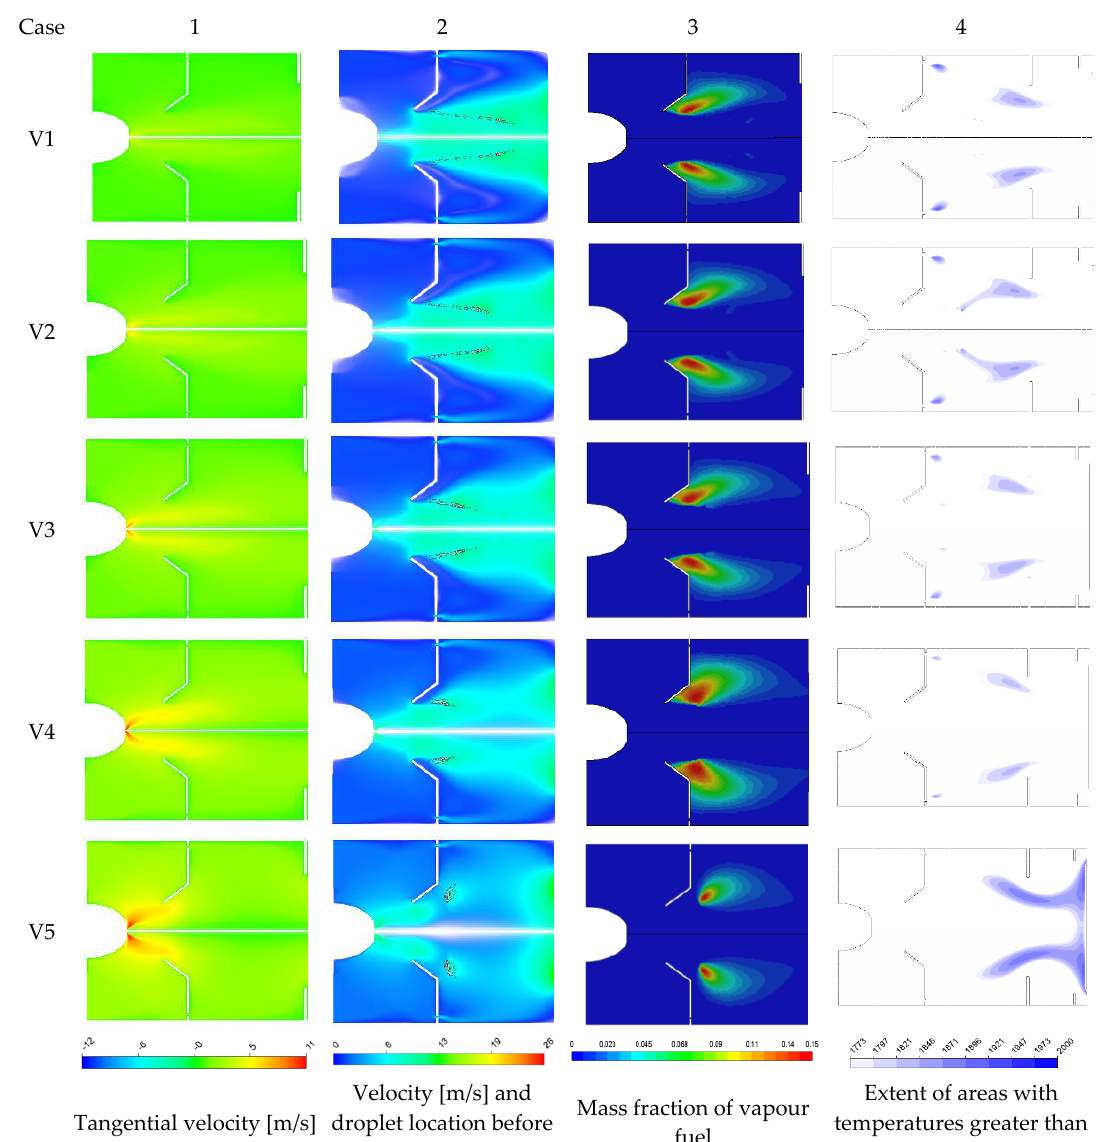
Figure 10. Simulation results for effect of increasing the inlet air swirl number from V1 to V5; ( column 1 ): contours of tangential velocity; ( column 2 ): contours of velocity together with lines presenting the droplets before evaporation; ( column 3 ): contours of mass fraction of evaporated fuel; ( column 4 ): contours of regions with high gas temperatures. The figures are zoomed in to show a closer view of the first sections of the combustion zone.